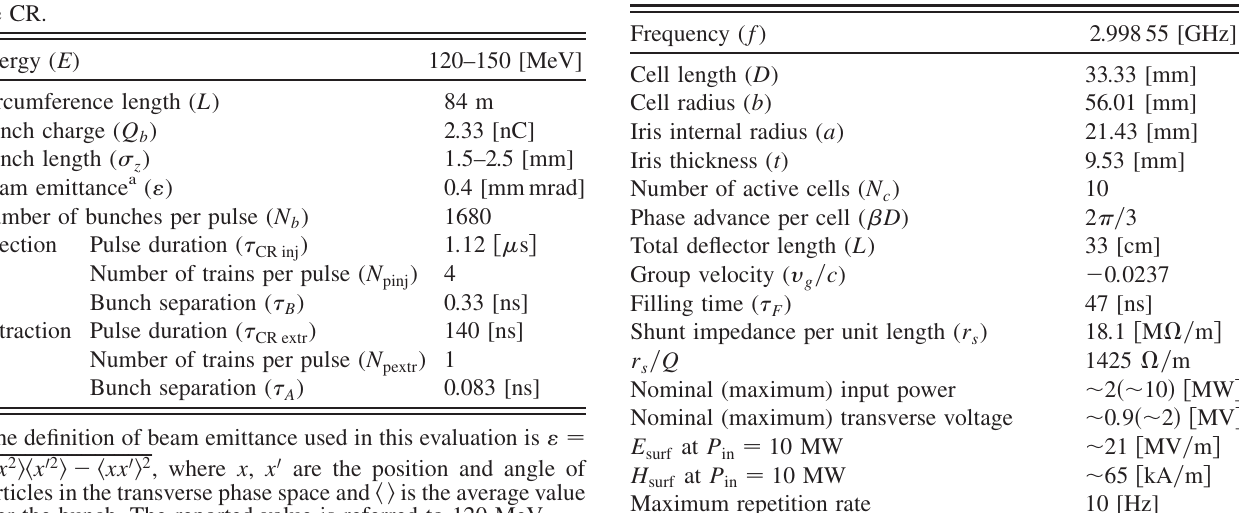
TABLE II. Combiner ring rf deflector parameters.